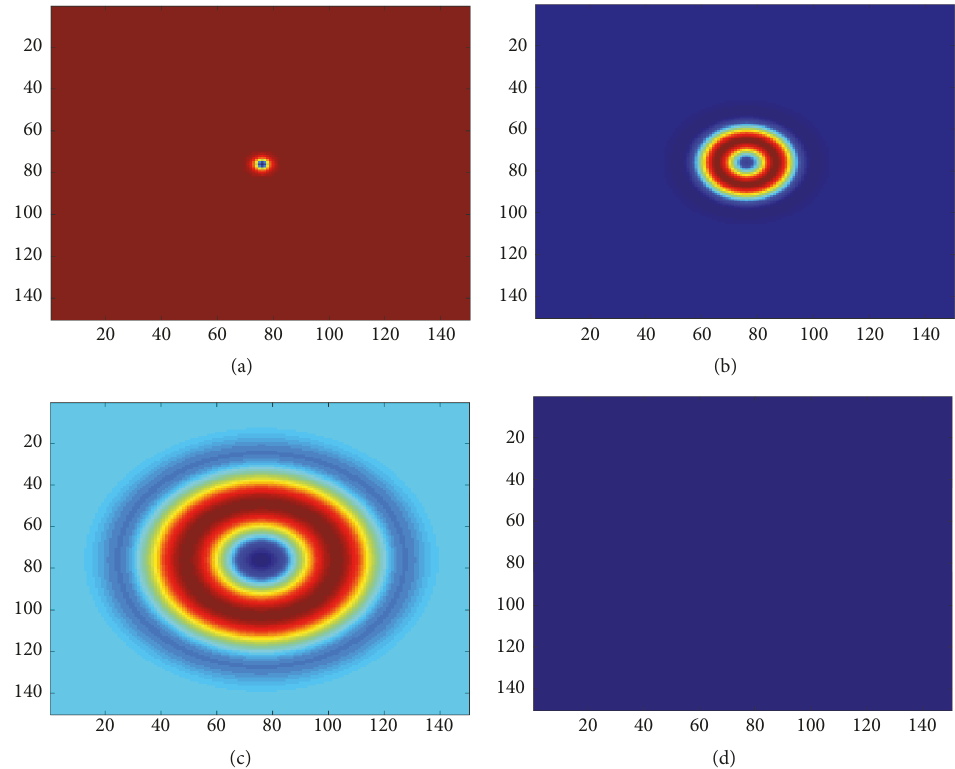
Figure 4: The snapshots of spatial distribution of membrane potential with color scale for neurons in the square array network for 𝑘 = 0.5 and 𝐷 = 5 at (a) 𝑡 = 2 time units, (b) 𝑡 = 20 time units, (c) 𝑡 = 100 time units, and (d) 𝑡 = 200 time units.